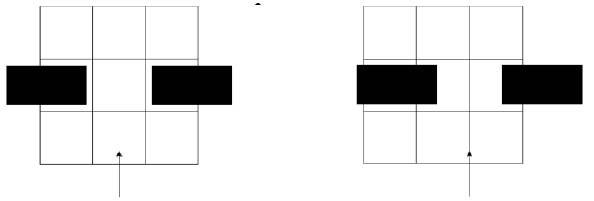
Figure 11. Example of how a valid path can be interpreted as both valid and invalid.